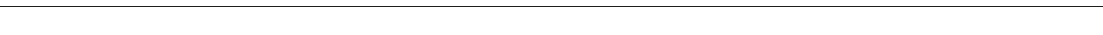
Fig. 9 UBR5 loss hastens aggregation and neurotoxicity in HD C. elegans models. a Western blot analysis of C. elegans with antibodies to GFP and β -actin loading control. The graph represents the Q67-YFP relative percentage values to Q67, vector RNAi-C. elegans corrected for β -actin loading control (mean ± s.e.m. of three independent experiments). b Filter trap analysis indicates that ubr-5 knockdown increases polyQ aggregates (detected by anti-GFP antibody) in C. elegans . The images are representative of four independent experiments. c Representative images of Q67-YFP aggregation under ubr-5 knockdown in whole adult worms. On the right, a higher magni fi cation of head neurons is presented. For higher magni fi cation of C. elegans mid-body, please see Supplementary Fig. 36. The images are representative of fi ve independent experiments. Scale bar represents 100 μ m. White arrows and red arrows indicate nerve ring and chemosensory processes, respectively. DIC, differential interference contrast. d Filter trap analysis with anti-GFP antibody of polyQ- expressing neuronal models in wild-type and rrf-3 ( pk1426 ) background. The images are representative of fi ve independent experiments. e Loss of ubr-5 hastens the motility defects of polyQ67 worms. Bar graphs represent average ( ± s.e.m.) thrashing movements over a 30 s period on day 3 of adulthood (Q19 fed vector RNAi ( n = 62) versus Q19 fed ubr-5 RNAi ( n = 64), P = 0.11; Q19 fed vector RNAi versus Q67 fed vector RNAi ( n = 65), P < 0.0001; Q67 fed vector RNAi versus Q67 fed ubr-5 RNAi ( n = 65), P < 0.0001). All the statistical comparisons were made by Student ’ s t- test for unpaired samples. ** P < 0.01, **** P <